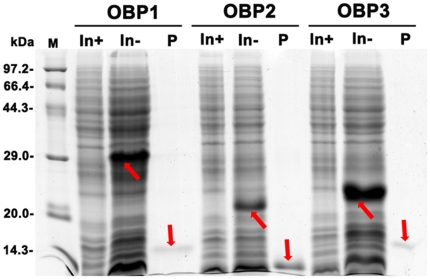
Expression and purification of three NlugOBPs.A SDS-PAGE was used to detect the OBP crude extracts from the bacterial pellets before (In-) and after (In+) induction with IPTG, and purified samples after His-tag cleavage by enterokinase (P). The target bands were marked by arrows.